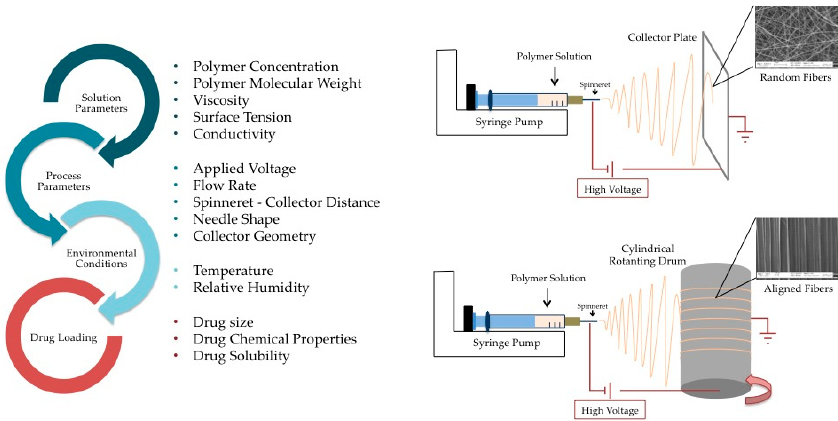
Figure 3. Electrospinning process. On the left, the parameters influencing fiber size, morphology, and density are listed; the physicochemical properties of the loaded drugs are also to be considered when the electrospinning technique is used for the fabrication of drug delivery systems. On the right, a schematic representation of the electrospinning apparatus with particular attention on the collector geometry, which is a crucial variable affecting fiber alignment. Scanning electron micrographs (Zeiss EVO MA10 (Carl Zeiss, Oberkochen, Germany)) show random dextran/alginate fibers and aligned polyethilenoxide/alginate ones.